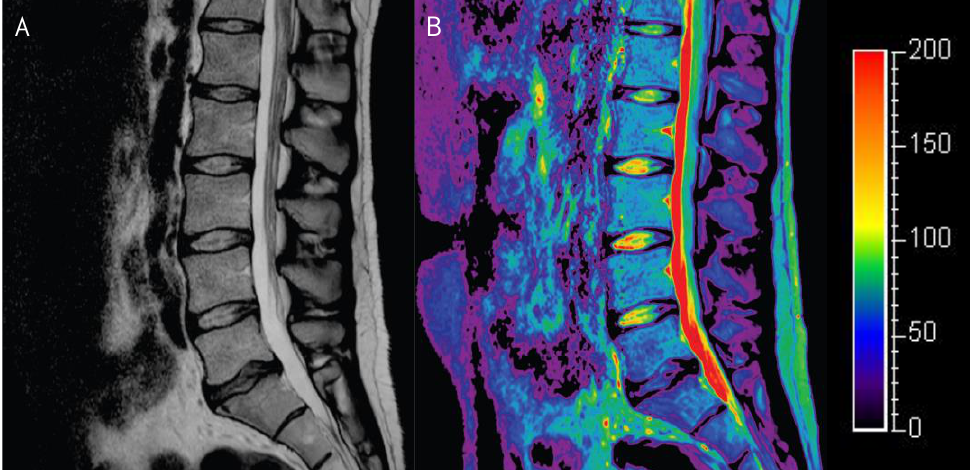
Figure 4. T2 mapping image. Lumbar spine MRI of an asymptomatic patient through ( A ) T2WI and ( B ) T2 mapping sequences. The T2 values of the L5/S disc, which is classified as Pfirrmann grade IV, also shows a decrease in T2 mapping intensity.